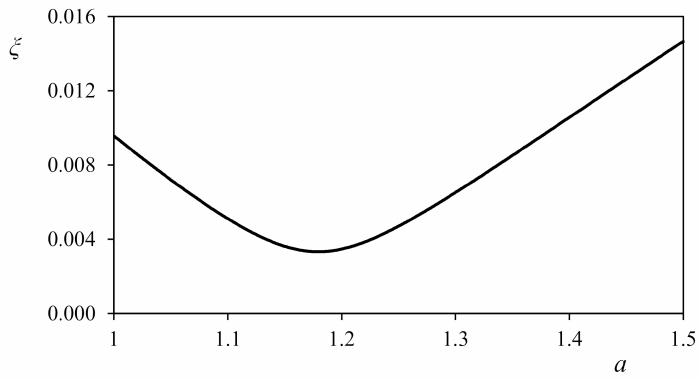
Figure 4. Non-dimensional RMSE, ξ , for a 1-D/2-R equivalent circuit model fitted to the I-V curve of an Emcore ZTJ solar cell (see Figure 1) versus the ideality factor, a . The value of the ideality factor, a , was studied with the aim of providing future researchers with an accurate but much simpler fitting of the 1-D/2-R equivalent circuit model. To carry out this analysis, the I-V curves from four solar cells and three solar panels were selected from previous works [56,81], as shown in Table 1. The parameters extracted by fitting Equation (1) to these I-V curves using Matlab © are given in Table 2. These fits were used as a reference for the values calculated analytically since it could be reasonably assumed that they were the most accurate ones for the I-V curves. It should also be remarked that the equations for the 1-D/2-R equivalent circuit model resulting from these fits may not exactly meet the requirements for the short circuit, MPP, and open-circuit conditions, as they represent the best fits not only to the three characteristic points but to a large number of additional points. Table 1. Solar cell/panel I-V curves used in the present work (where n is the number of series-connected cells for each of these photovoltaic devices; T is the temperature; and the characteristic points are I sc , I mp , V mp , and V oc ). Solar Cell/Panel